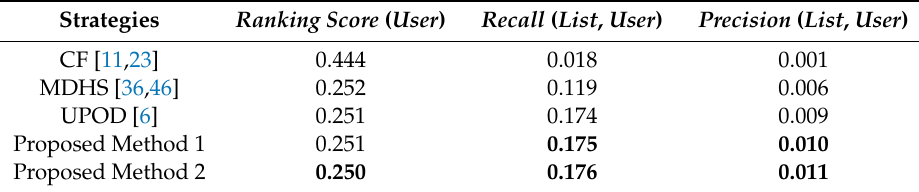
Table 3. Comparison of µ for the proposed methods with existing strategies— Last.FM .